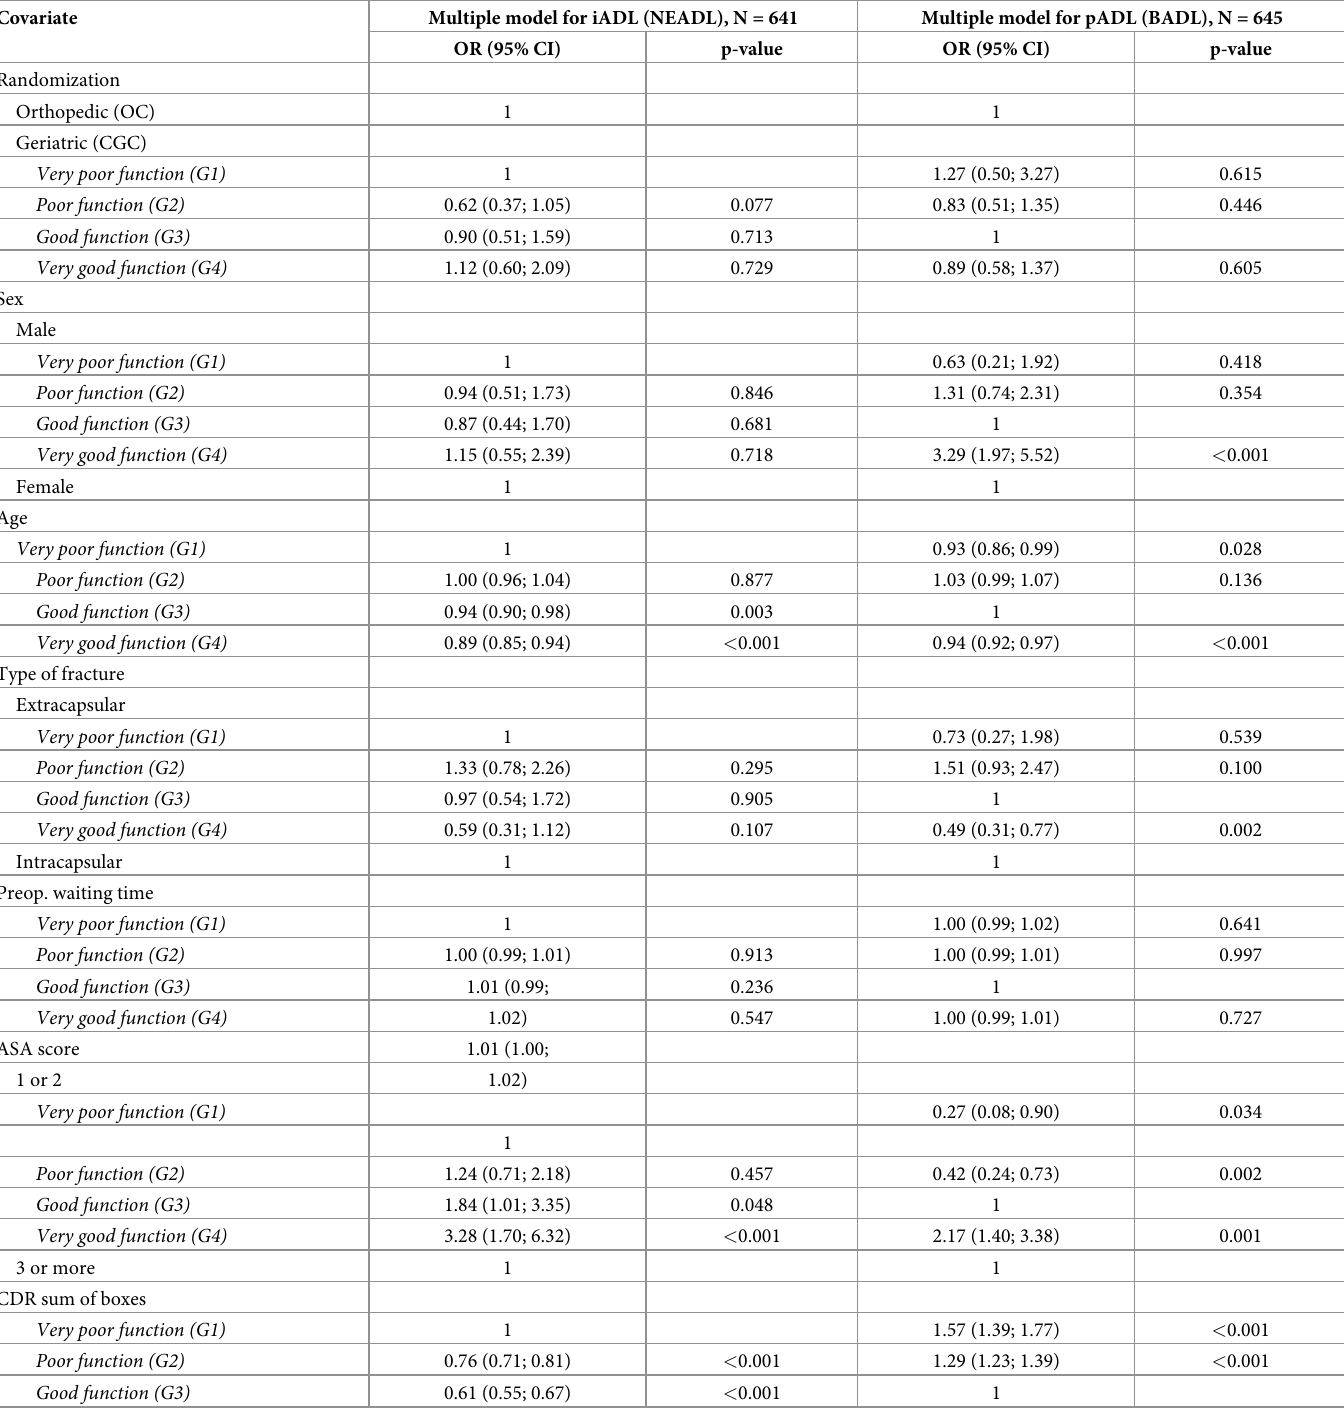
Table 4. Results of the multiple nominal regression